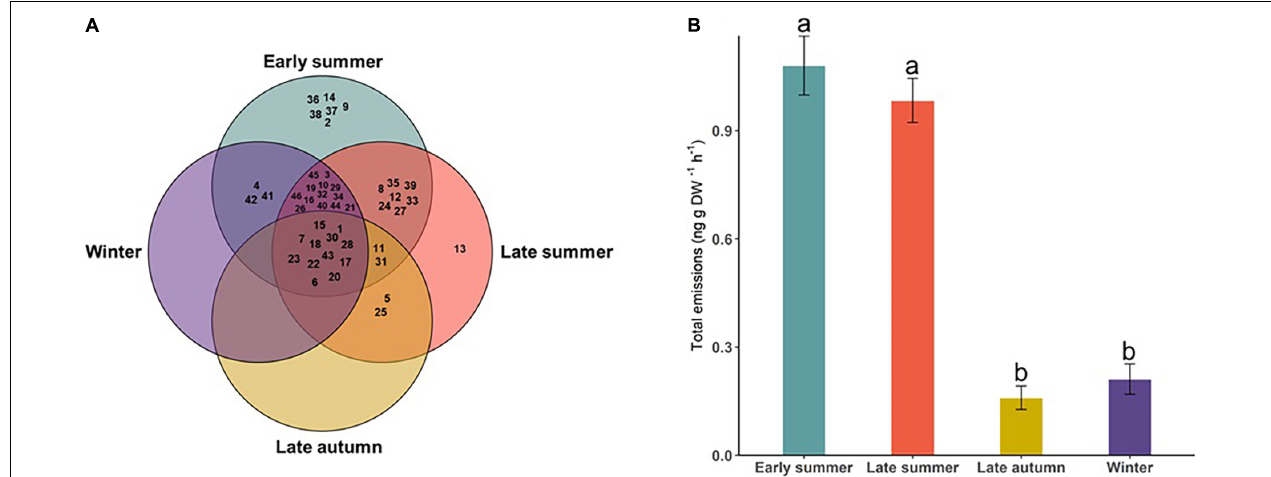
FIGURE 2 | (A) Volatile compounds identified in the headspace of D. subulatum on sampling occasions. Numbers in the chart represent the codes assigned to compounds in Table 1 . (B) Comparison of total volatile emissions of D. subulatum between the four sampling occasions ( n = 25). Bars show log-transformed mean ± SE emissions. Different letters indicate significant differences between groups.